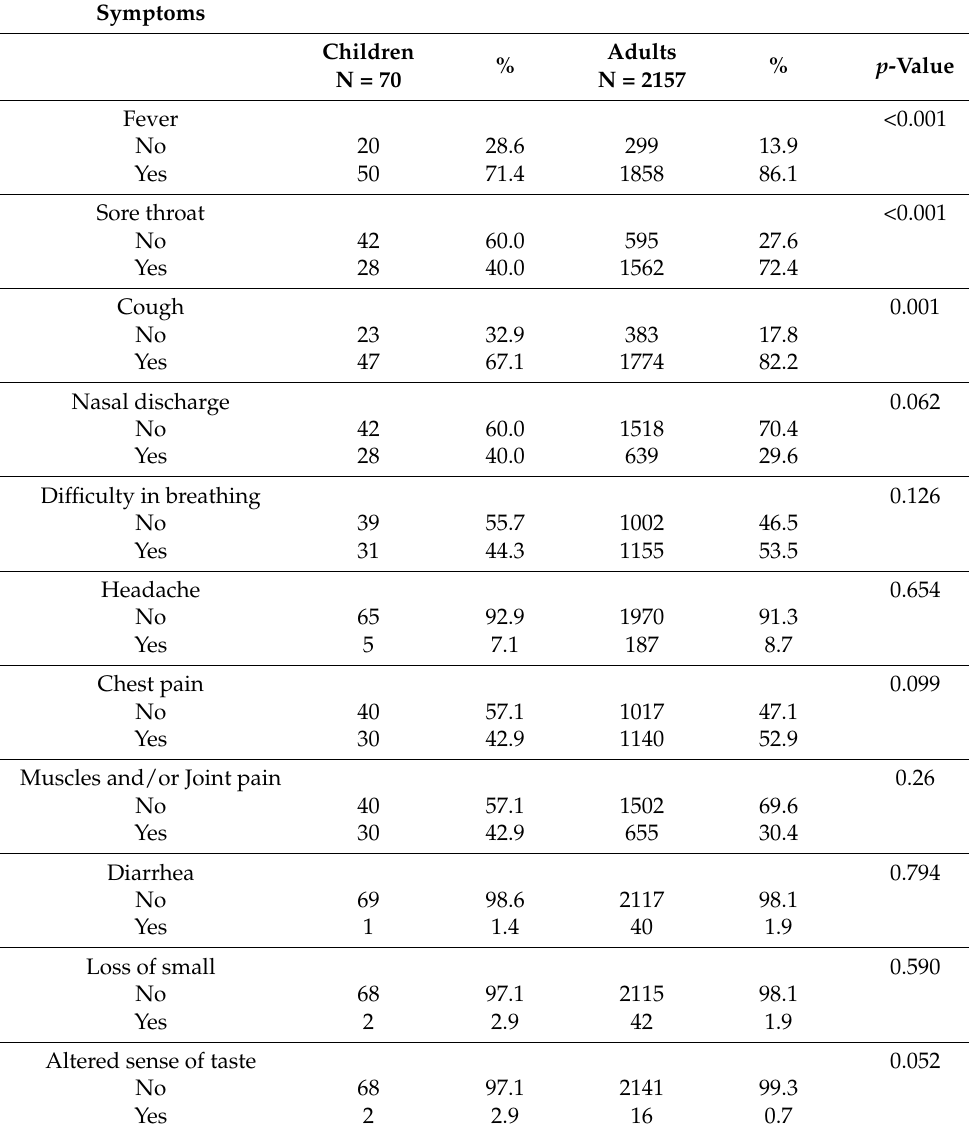
Table 3. Comparison of Reported Symptoms in RT-PCR Confirmed Cases by Age